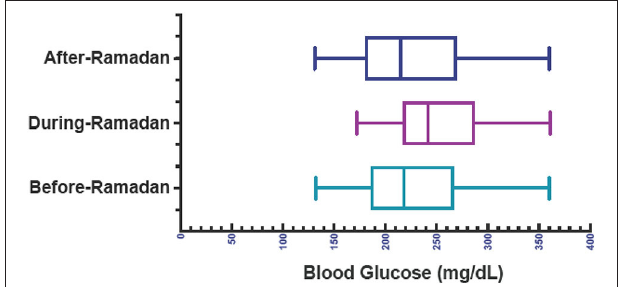
FIGURE 2 | Blood glucose levels before-, during-, and